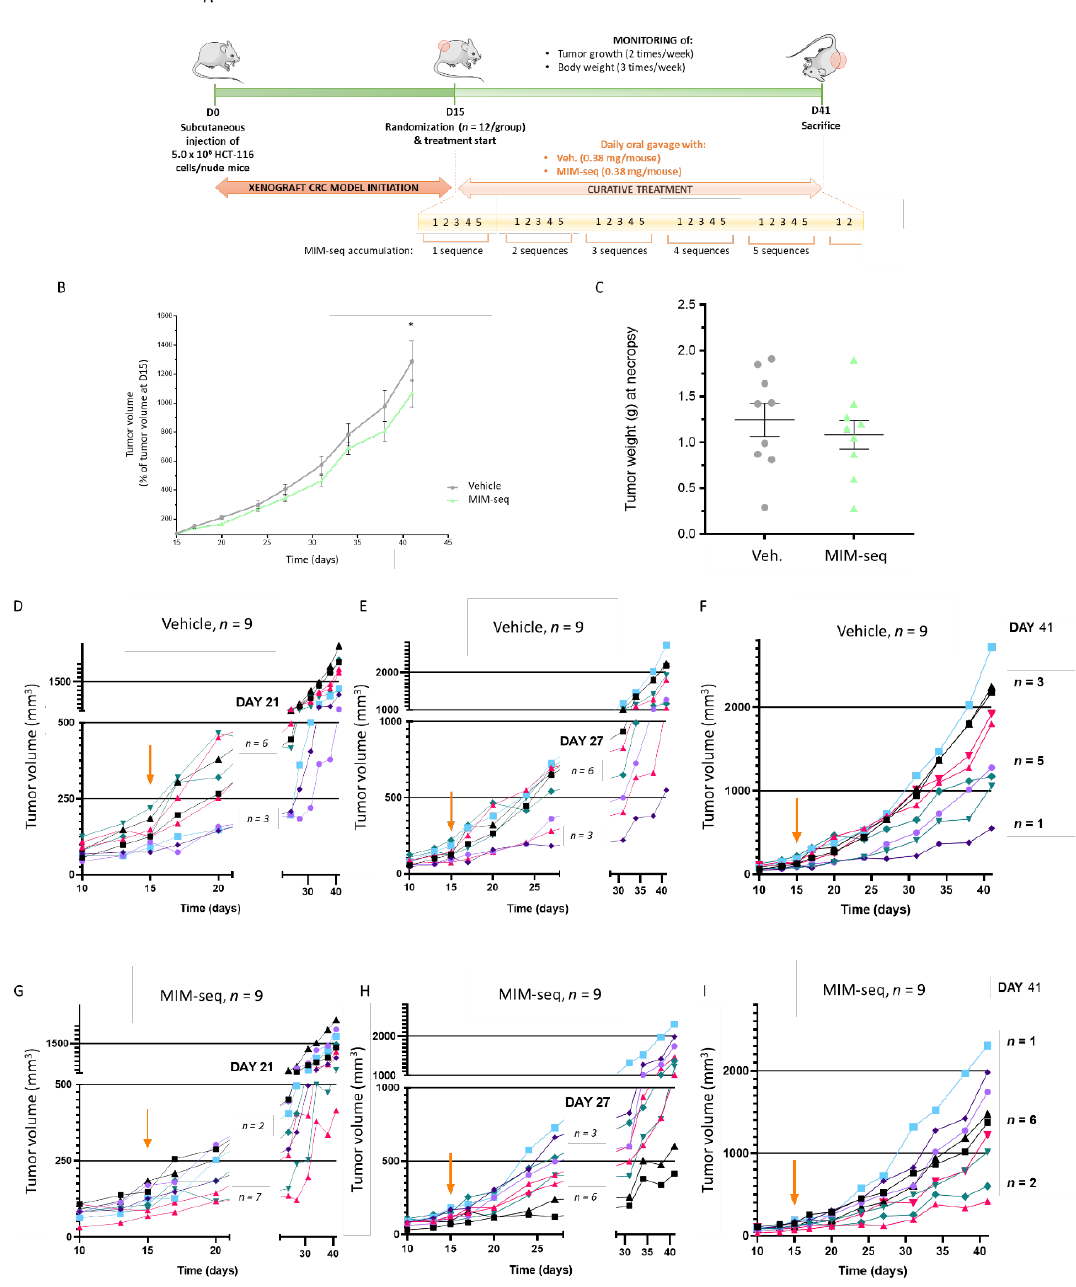
Figure 4. MIM-seq displays slight anti-tumor effects in a subcutaneous xenograft model of colon carcinoma. ( A ) Experimental scheme of the in vivo study. Briefly, HCT-116 cells were subcutaneously implanted into the left flank of each mouse on Day 0 (D0) and tumor-bearing animals were block-randomized into two groups (MIM-seq and Veh.) on Day 15 (D15). Starting from D15 to Day 41 (D41), each group was daily treated by oral gavage wi th 0.38 mg/100 μL water/mouse of Veh. or MIM- seq. Mice’s body weights and tumor growth were monitored during the treatment course. The experiment was ended on Day 41, when the animals were euthanized and the tumors were necropsied. ( B ) Tumor volume evolution is displayed from D15 to D41, as percentages of animal tumor volumes at D15 ( n = 9 in each group) ± SD. The mean evolution of tumor growth between D15 and D41 was compared between groups with linear mixed models for repeated measures ( p = 0.02 at D41). ( C ) Tumor weights were measured at necropsy (D41). The tumor weights ( p = 0.48) are represented with scatter plots and mean ± SD. The two groups are compared with Wilcoxon-Mann-Whitney tests. ( D – I ) The graphs represent the evolution of tumor volume, from D10 to D41, in each mouse of Veh.-treated group ( D – F ) and MIM-seq-treated group ( G – I ). The orange arrow in graphs indicates the day of starting treatment (D15). The graphs were